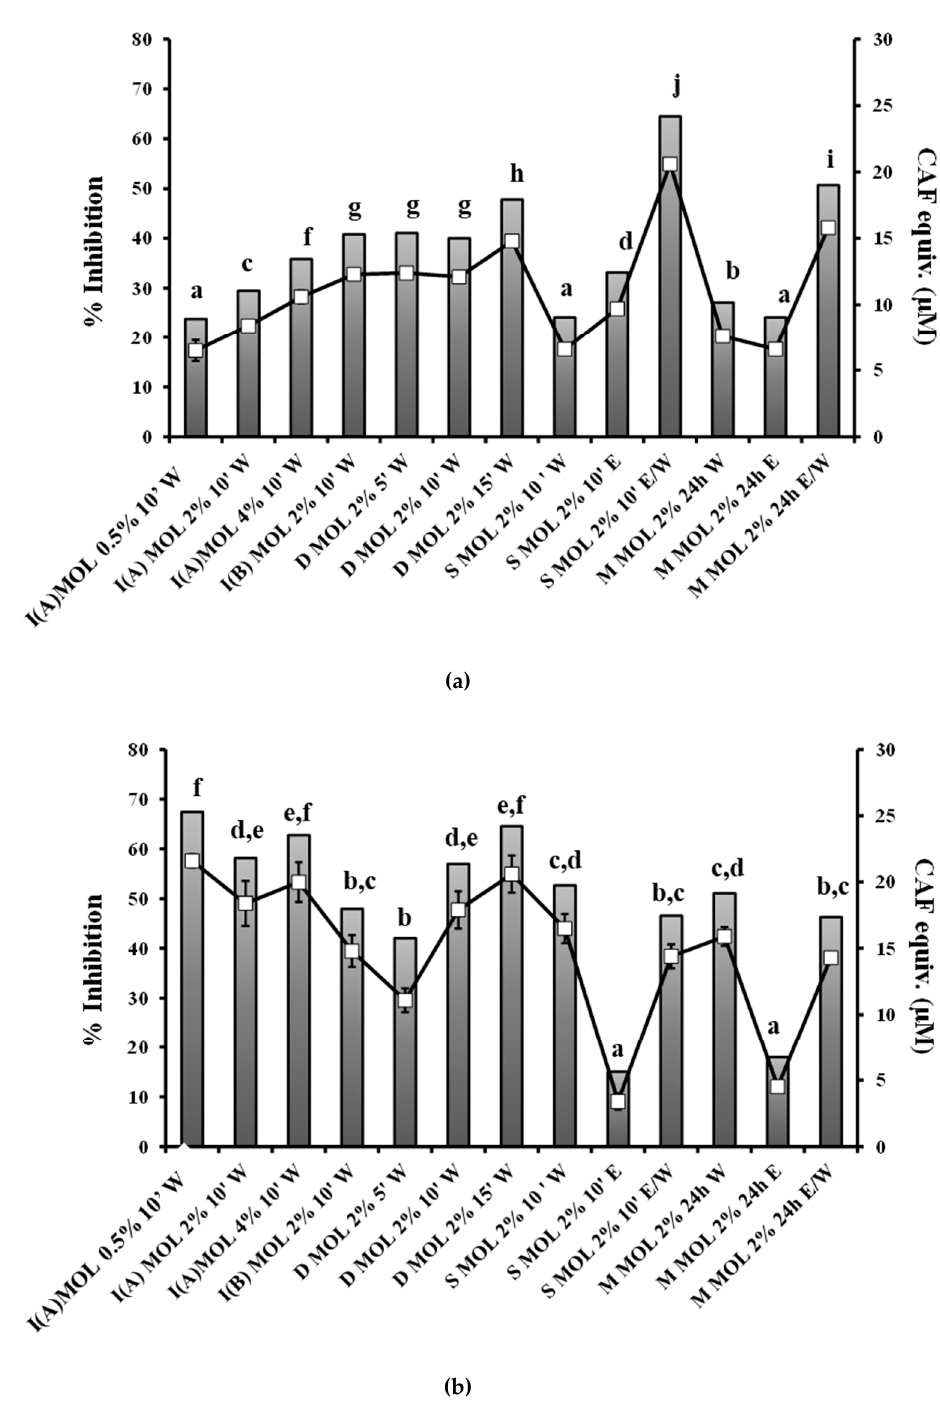
Figure 3. DPPH radical scavenging activity (expressed as %Inhibition and CAF µ M equivalents) of MOL preparations. ( a ) same TP content basis; ( b ) same dry extract weight basis.